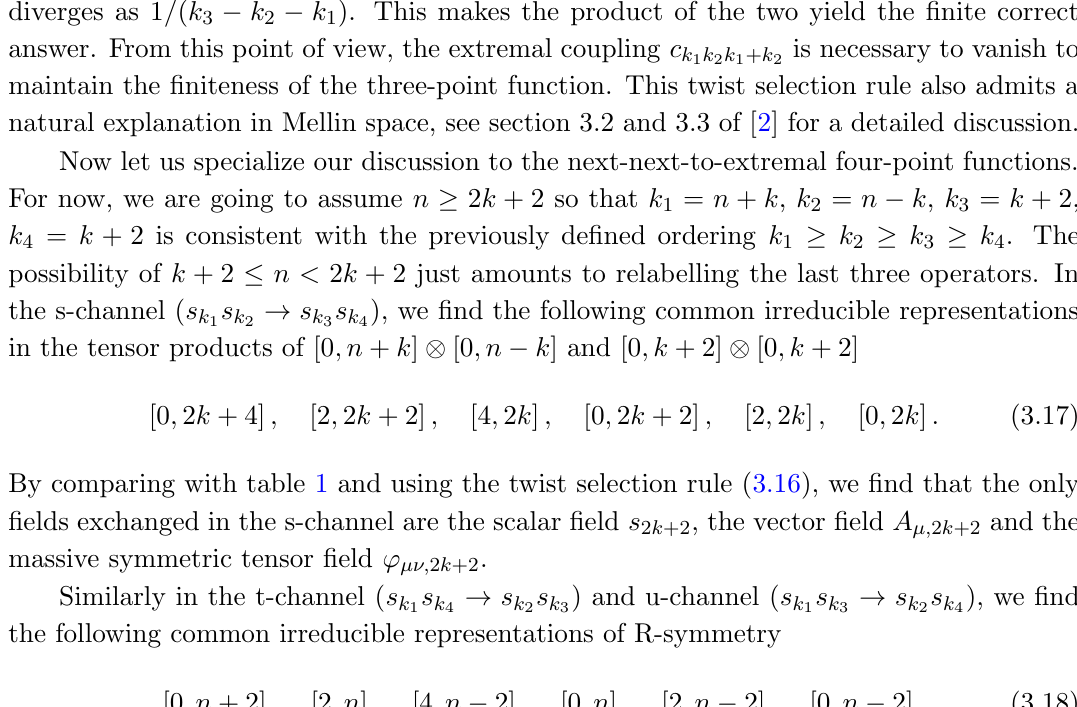
, A and ’ 2 n (cid:22); 2 n (cid:22)(cid:23); 2 n